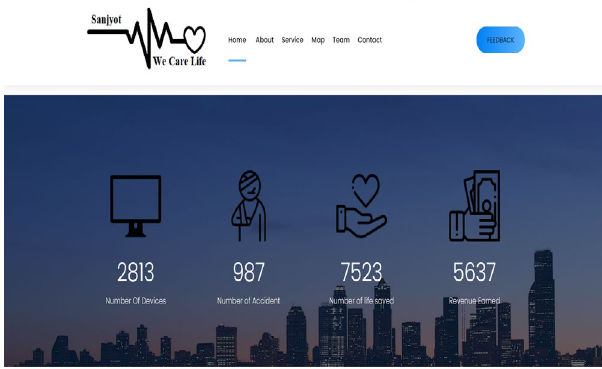
Figure 15. Output of GPS